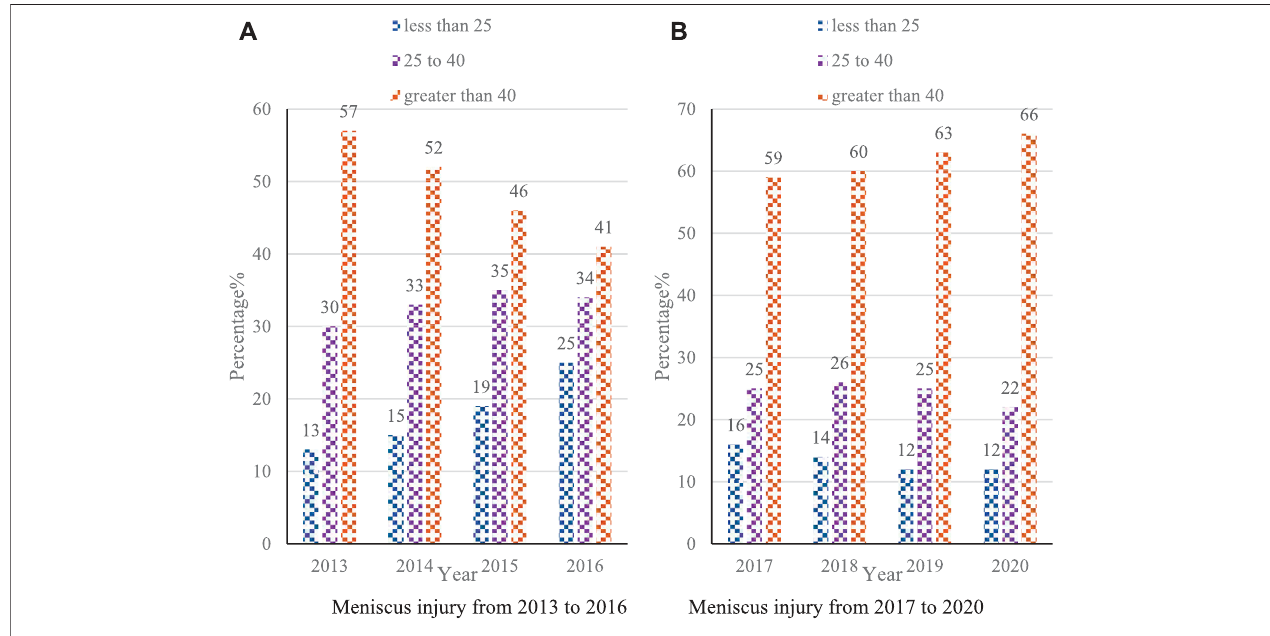
FIGURE 1 | Age ratio of meniscal injuries from 2013 to 2020. (A) Meniscus injury from 2013 to 2016 (B) Meniscus injury from 2017 to 2020.